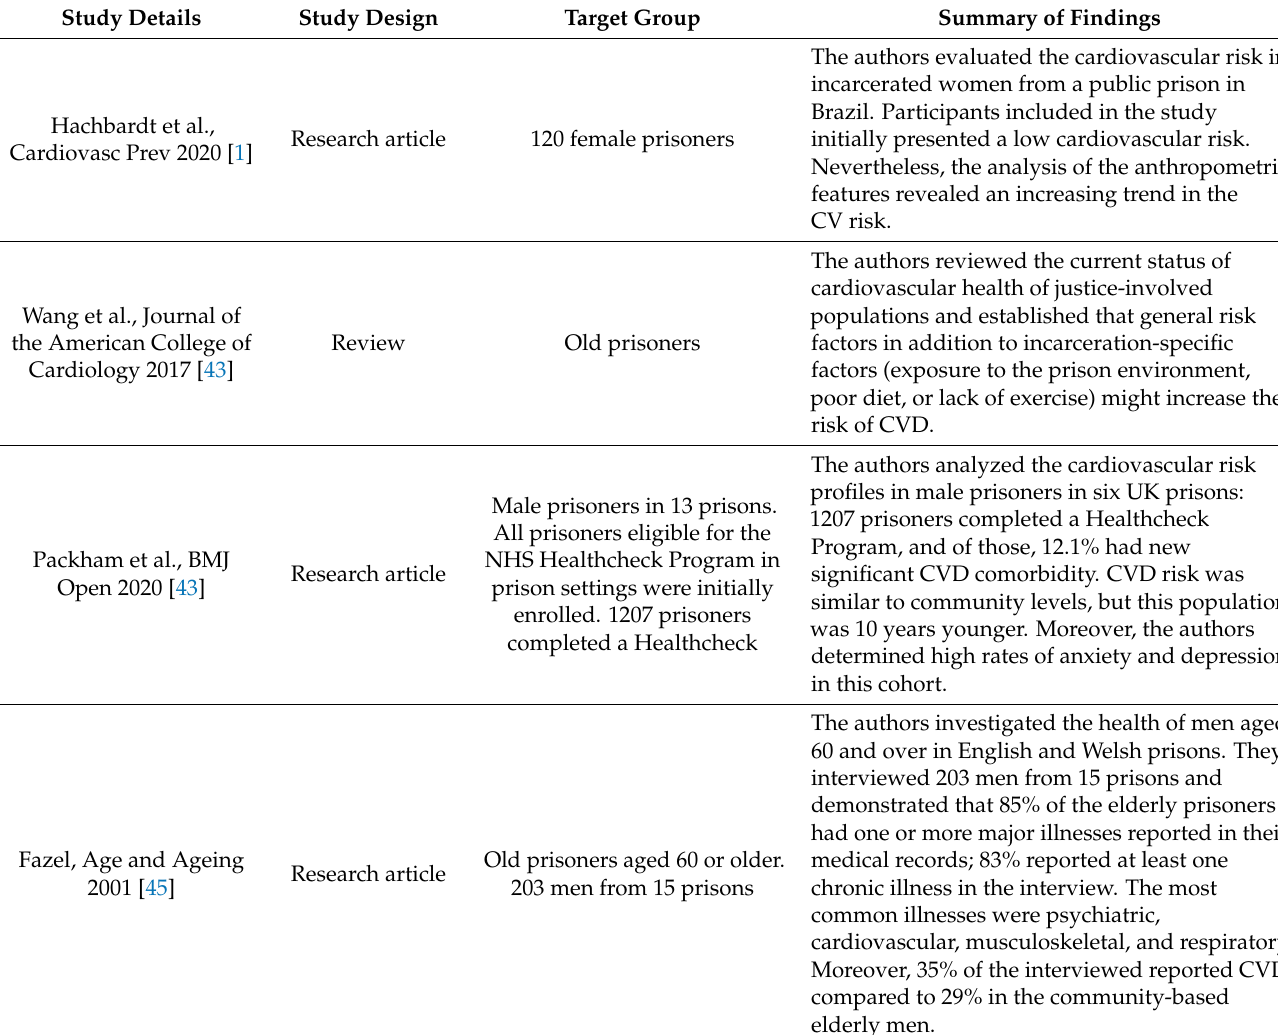
Table 3. Summary of the finding of the five studies evaluating the incidence of CVD and CHD in the prison